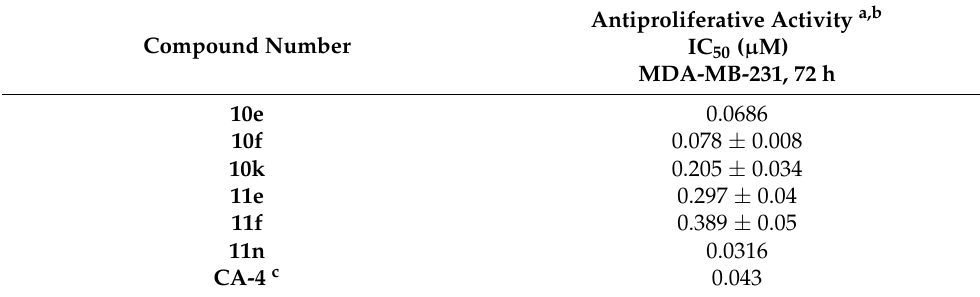
Table 4. Antiproliferative Effects of Selected β -Lactam Compounds in MDA-MB-231 Human Breast Cancer